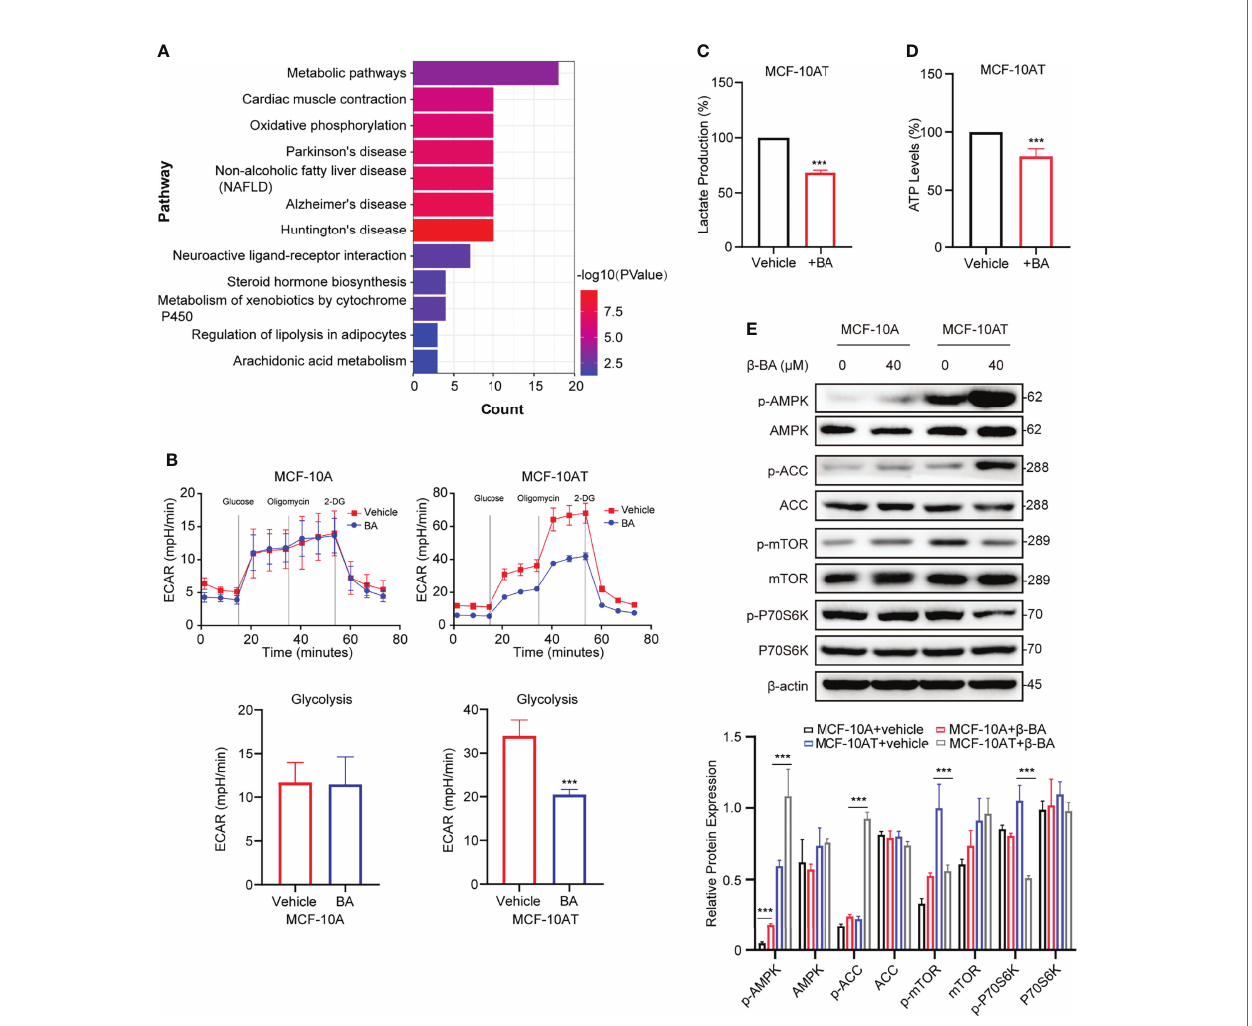
FIGURE 3 | b -BA suppresses glycolysis and activates the AMPK pathway in MCF-10AT. (A) KEGG pathway enrichment analysis was performed with predicted targets derived from BATMAN-TCM. (B) The cellular ECAR was measured in MCF-10A and MCF-10AT cells with or without b -BA treatment. Statistics of glycolysis ECAR values are shown in the lower panel. The lactate production (C) and ATP levels (D) were measured in MCF-10AT cells with or without b -BA treatment. (E) The expression levels of AMPK, p-AMPK, ACC, p-ACC, mTOR, p-mTOR, p70S6k, and p-p70S6k were analyzed in MCF-10A and MCF-10AT following a 48-h treatment with 40 m M b -BA. Protein levels were quanti fi ed by ImageJ and normalized with that of b -actin in the lower panel. Data were shown as the mean ± S.D from independent experiments. *** p <